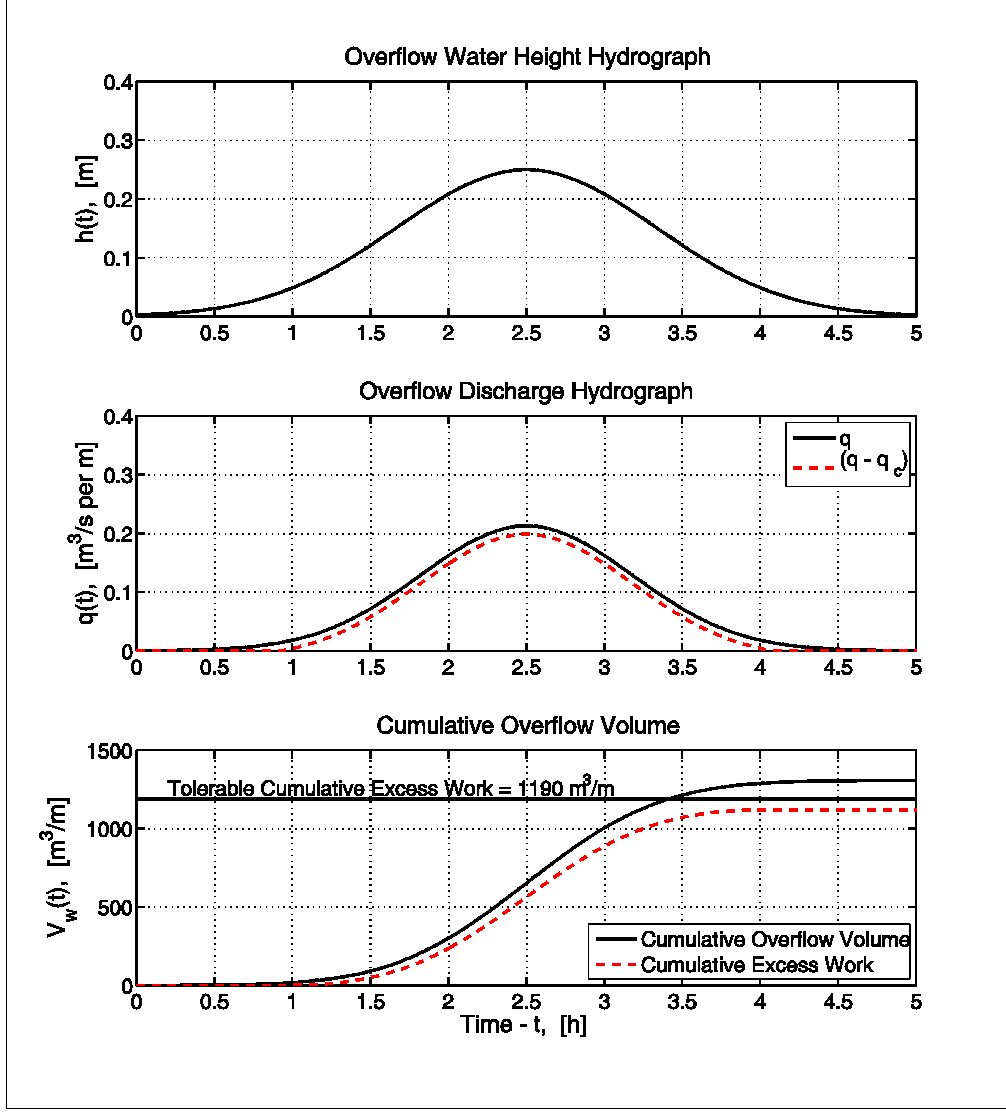
Figure 6. Example of cumulative excess work estimate for “good grass” ( u c = 1.8